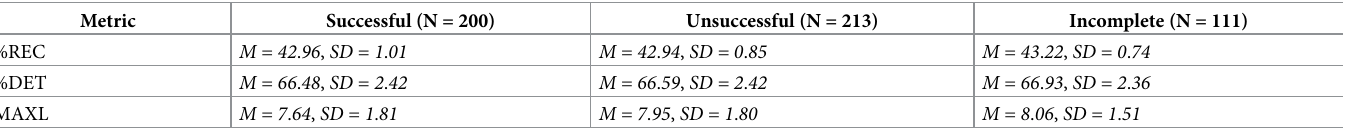
Table 1. Results of the statistical analyses for H1 are available in Table 2. Table 1. Descriptive statistics for general MdRQA for successful, unsuccessful, and incomplete